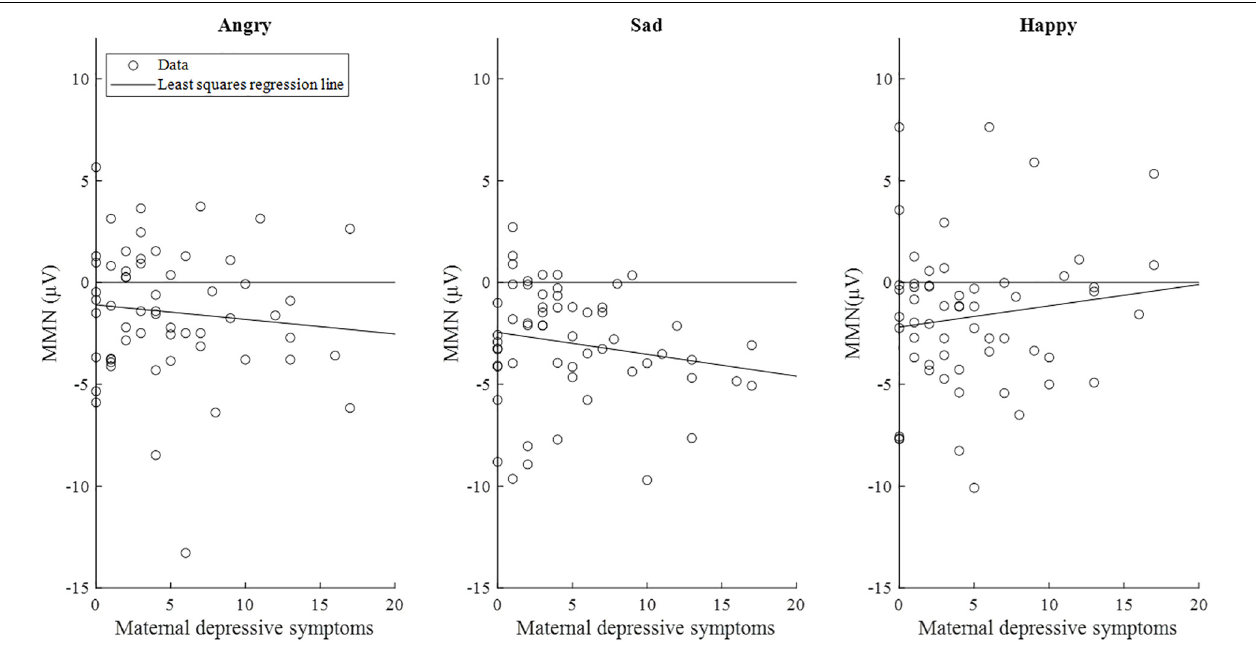
FIGURE 5 | Scatterplots of maternal depressive symptoms and the mismatch response amplitudes ( µ V) of the children ( n = 58) in the early time window (80–120 ms). Of note, the lines are least-squares regression lines fitted across the data points, not the results of the mixed-effects models.